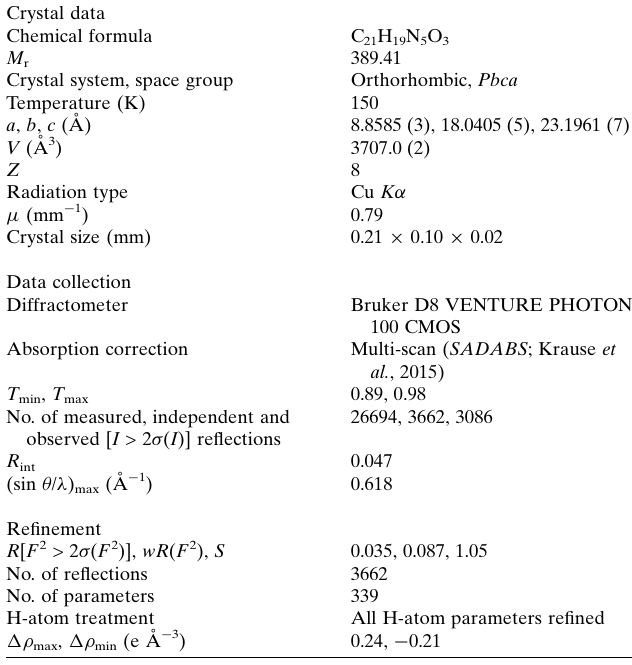
Table 1 Hydrogen-bond geometry (A˚ , (cid:2) ). Cg 1 is the centroid of the triazole ring.